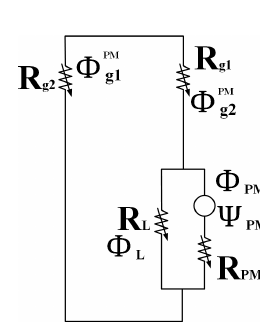
Figure 3. Boundary conditions of the leaf ring.